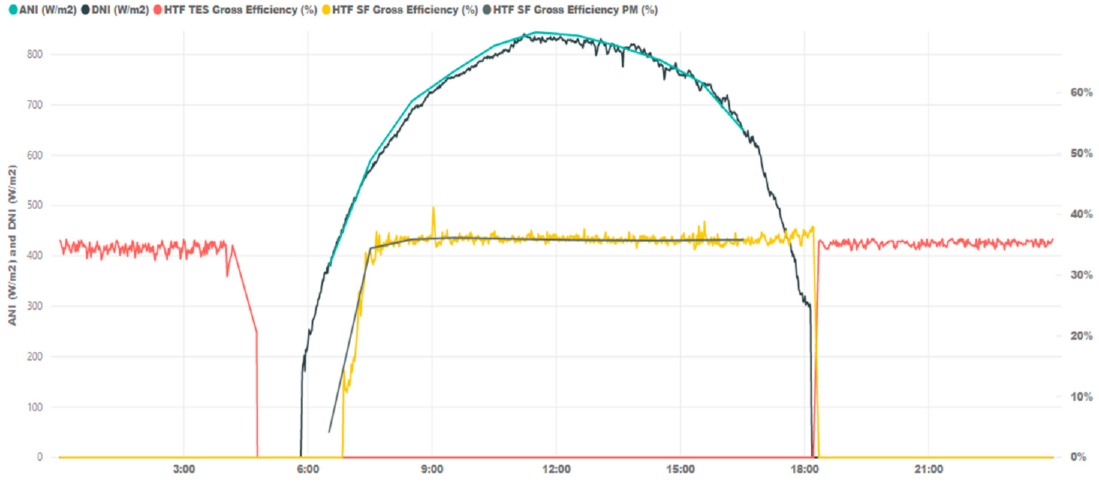
Figure 9. Turbine efficiency vs DNI.